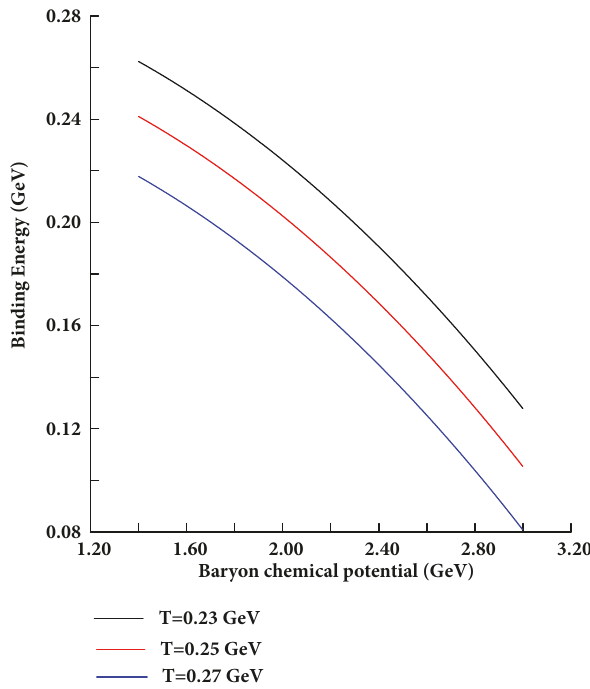
Figure 9: The binding energy 1S charmonium is plotted as a function of baryonic chemical potential for different values of temperature at 𝜉 =